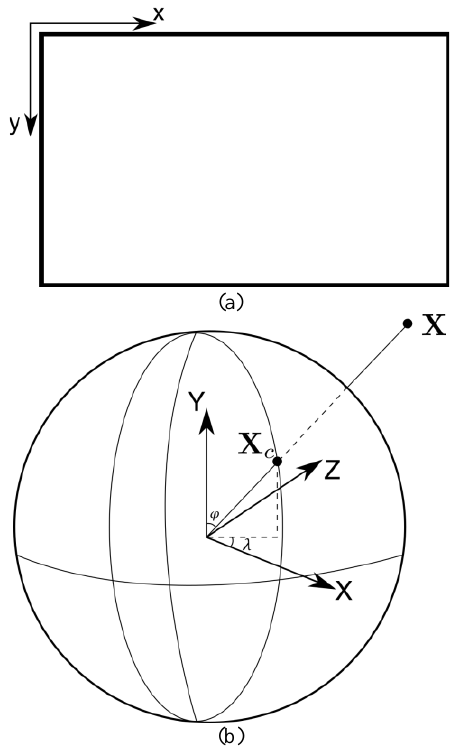
Figure 2 . Coordinate systems of frame-based image in (a), and spherical in